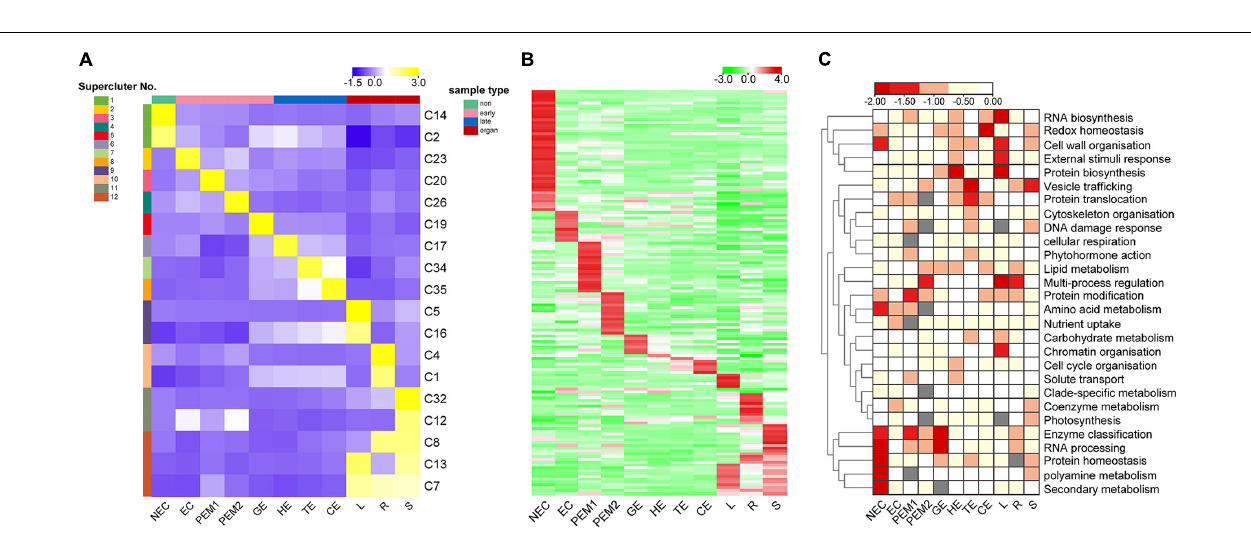
FIGURE 5 | K-means clustering reveals unique tissue- and/or stage-specific expression trends. (A) Eighteen clusters representing 6,815 genes are shown with distinct stage- and tissue-specific expression patterns. Averaged Normalized FPKM of all the genes in each cluster was used to generate the heat map. These clusters are further grouped into 12 superclusters shown to the right. Heat map indicate the gene expression level by gradient color scale in which yellow indicates high expression. (B) Clustering based on Normalized FPKM of 142 transcription factors. Red scale indicates high expression. (C) Enriched MapMan bins shown to the right for each of the 12 superclusters. Significant enrichment is indicated by low P